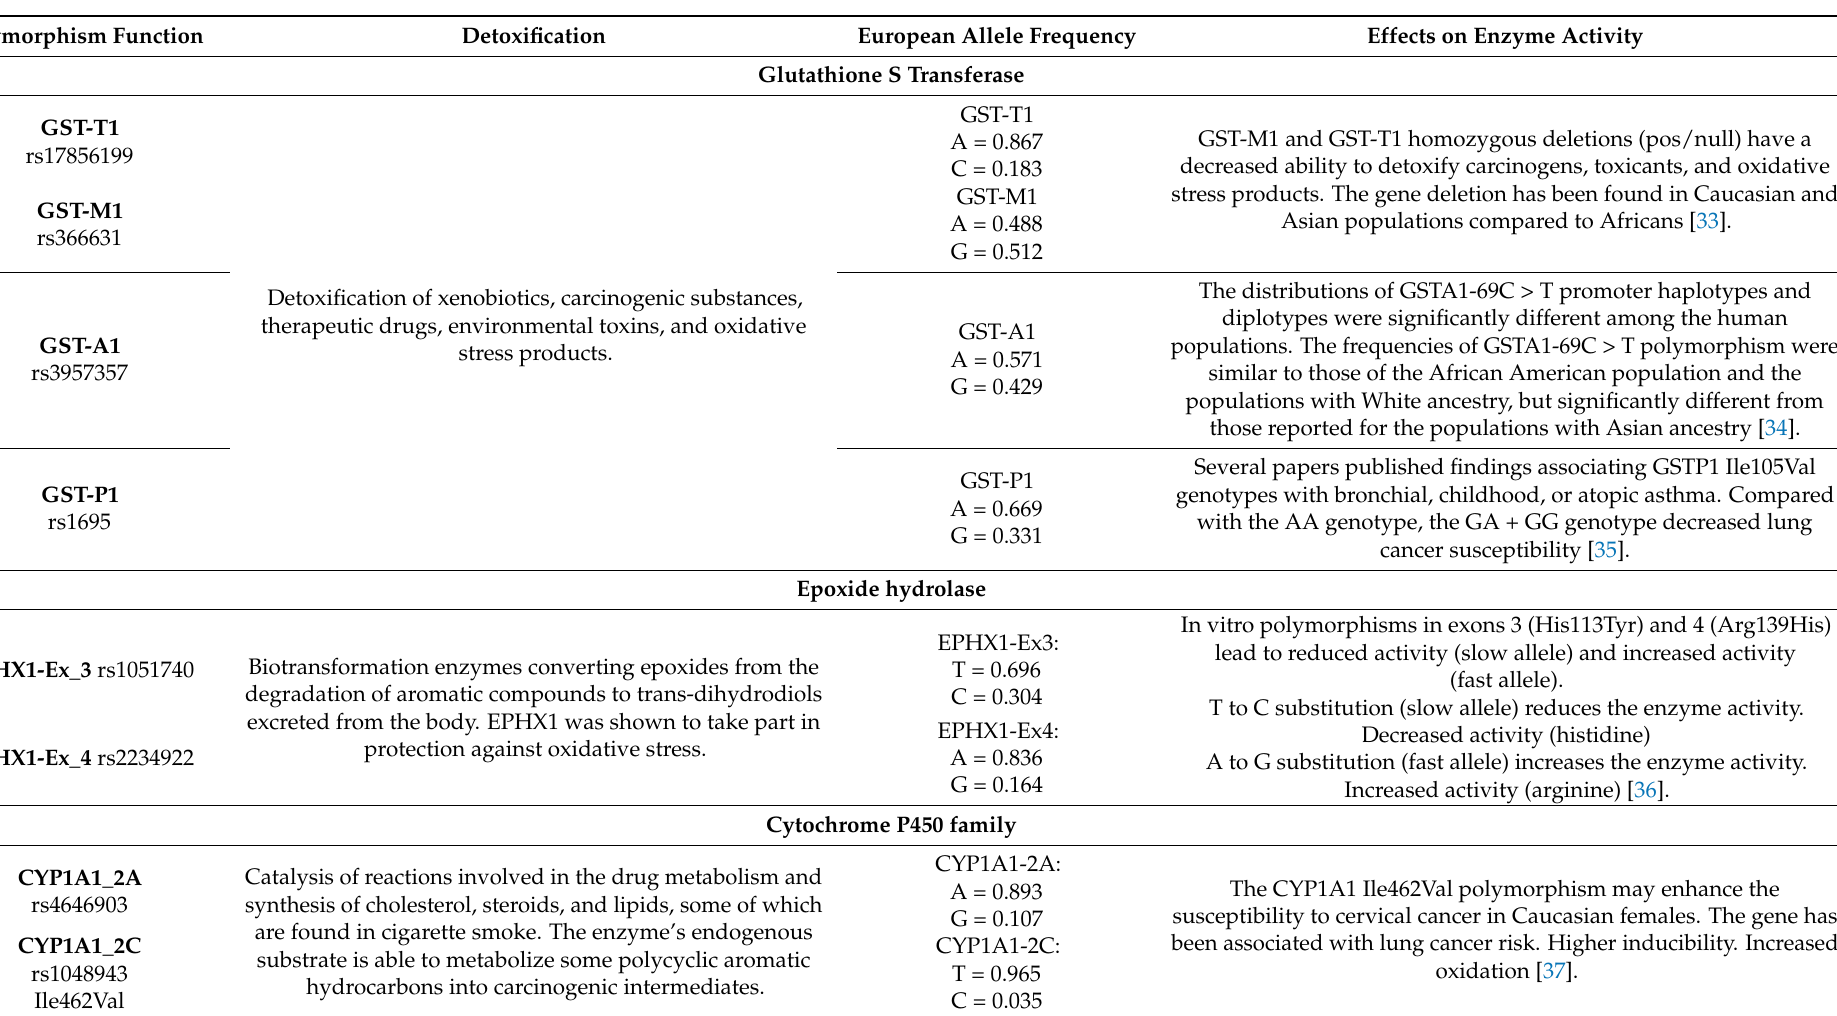
Table 1. List of specific gene polymorphisms and relative enzymes relevant to the human